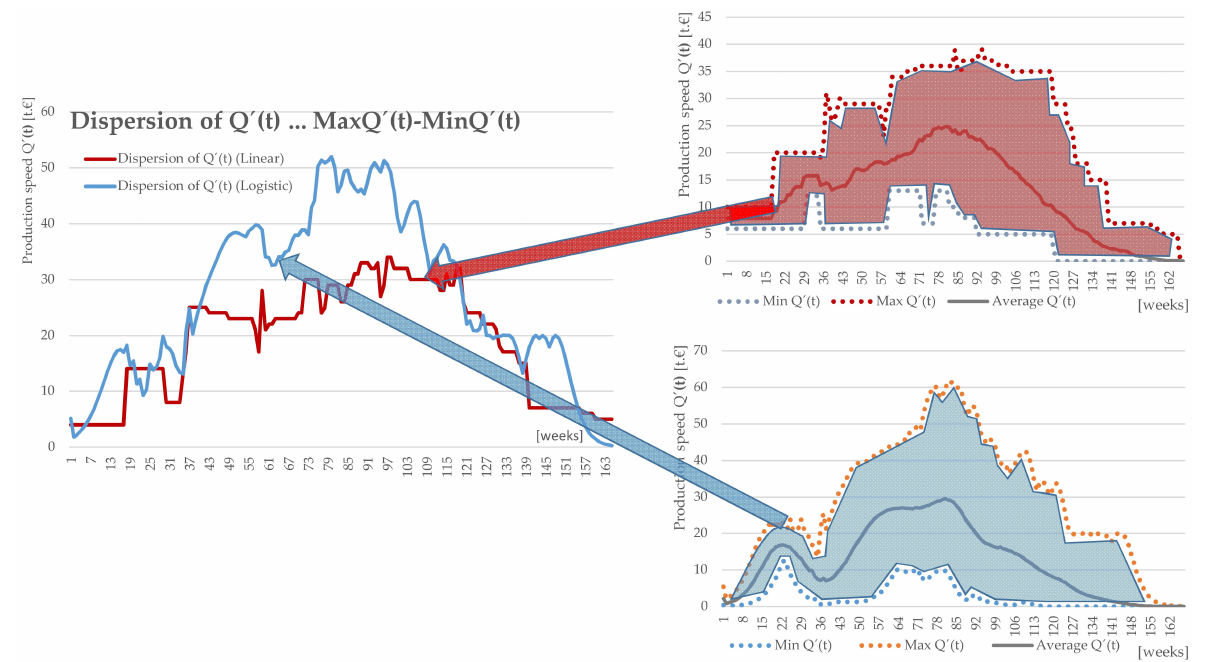
Figure 5. Dispersion of production rates Sim (100 × ), time series Max Q (cid:48) ( t )–Min Q (cid:48) ( t ), linear and logistical resource distribution. (Source: authors).